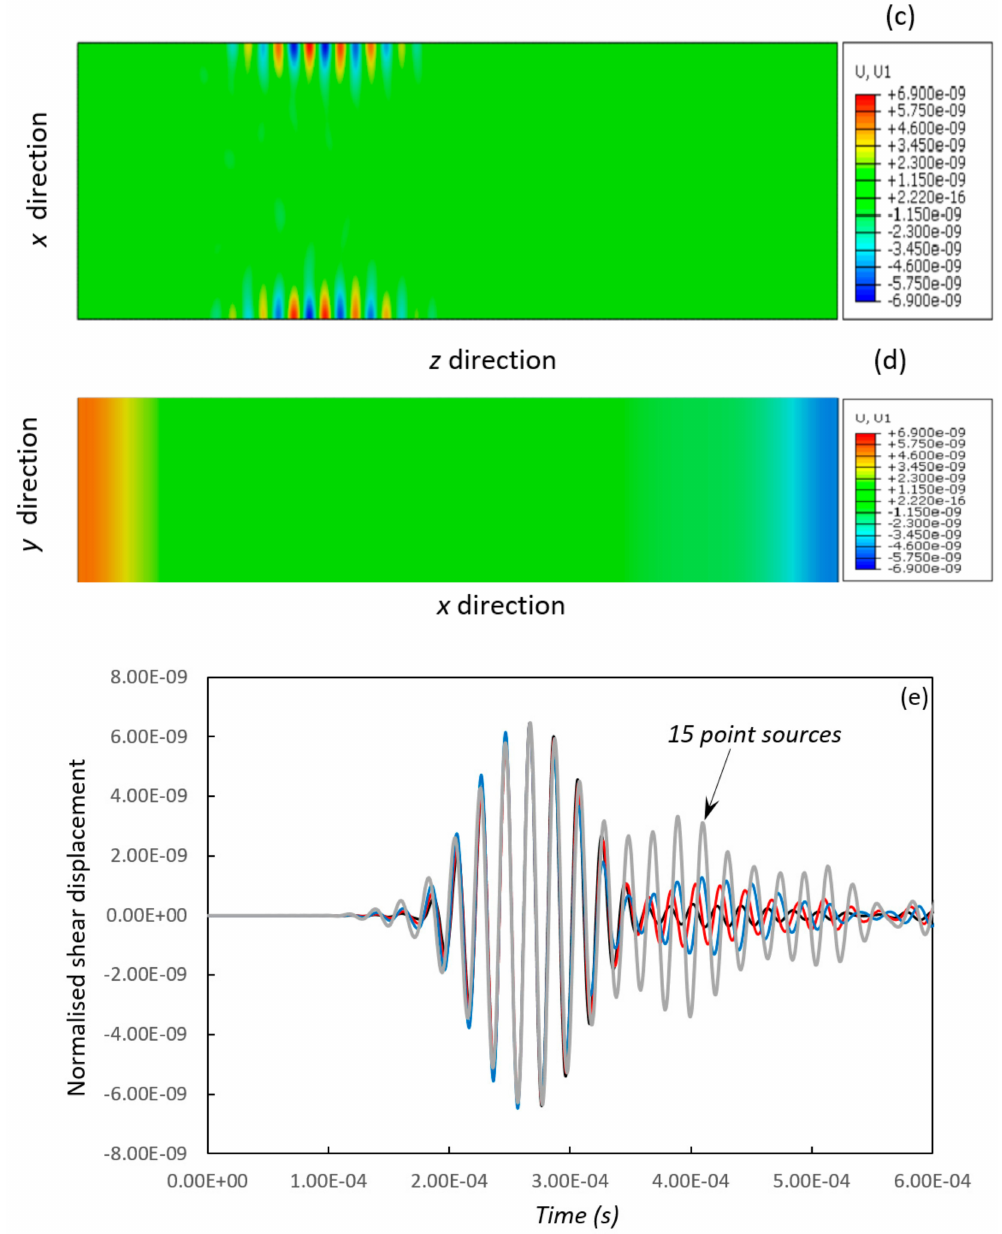
Figure 6. Excitation of Rayleigh mode S0*: ( a ) shear displacement loading; ( b ) extensional displacement loading; ( c ) generated shear displacement distribution (top view); ( d ) generated shear displacement distribution (transverse view); ( e ) time domain displacement at receiver